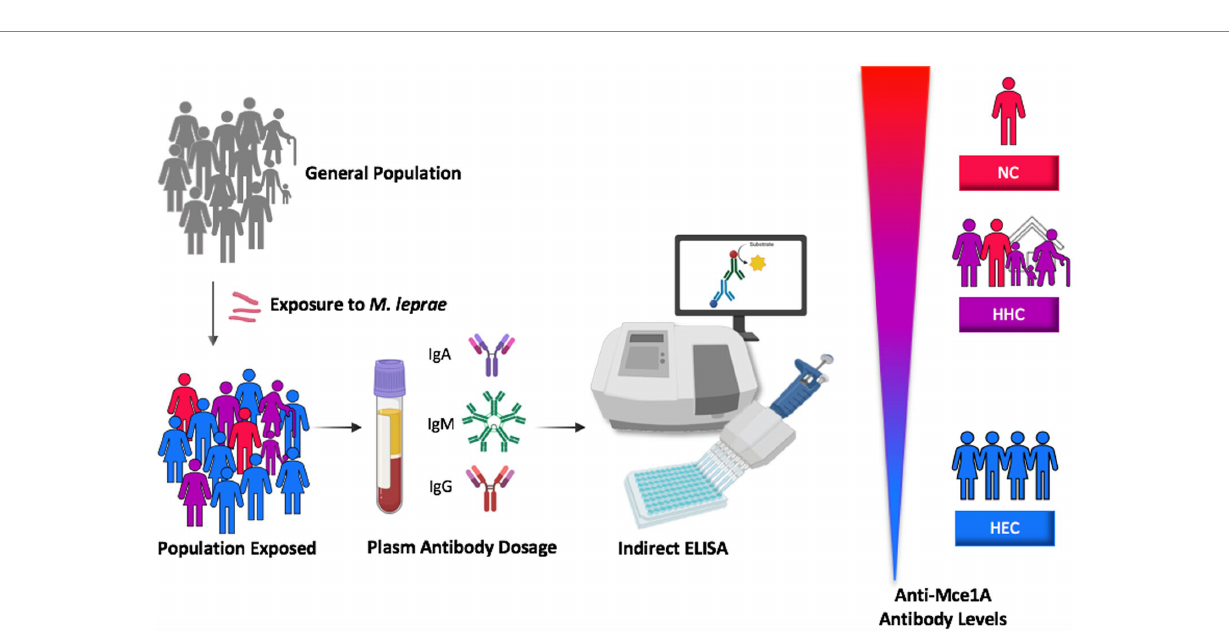
FIGURE 6 Proposed model of the stimulus and utility of specific antibodies against Mce1A protein in the laboratory diagnosis of HD based on the level of seropositivity for patients, household contacts and endemic controls. HEC, healthy endemic controls; HHC, household contacts of HD patients; NC, new cases of HD; Mce1A, mammalian cell-entry protein